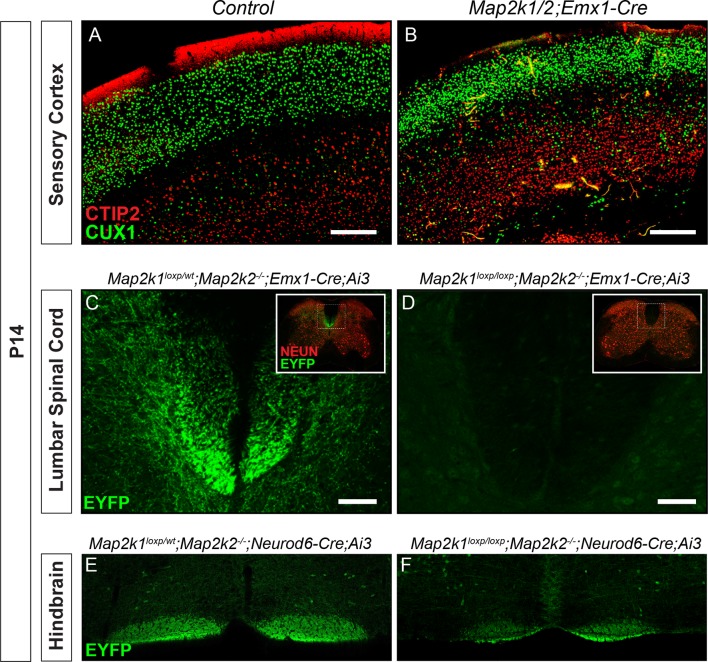
Reduced number of corticospinal neurons following loss of Map2k1/2.(A–B) Similar to results with Neurod6-Cre mice, deletion of Map2k1/2 with Emx1-Cre also led to a disruption of CTIP2 labeling in layer 5 sensorimotor cortices in Map2k1/2;Emx1-Cre mice (B) when compared to controls (A) (n=3, scale bar=200 µm). (C–D) Visualization of the CST in spinal cord cross-sections of P14 Map2k1/2;Emx1-Cre;Ai3 mice revealed a near complete absence of corticospinal axons in the lumbar segment of the spinal cord compared to control (E) (n=3, scale bar=50 µm). (E–F) The size of the EYFP labeled CBT was reduced in P14 Map2k1/2;Neurod6-Cre;Ai3 hindbrains (F) when compared to controls (E) (n=3).